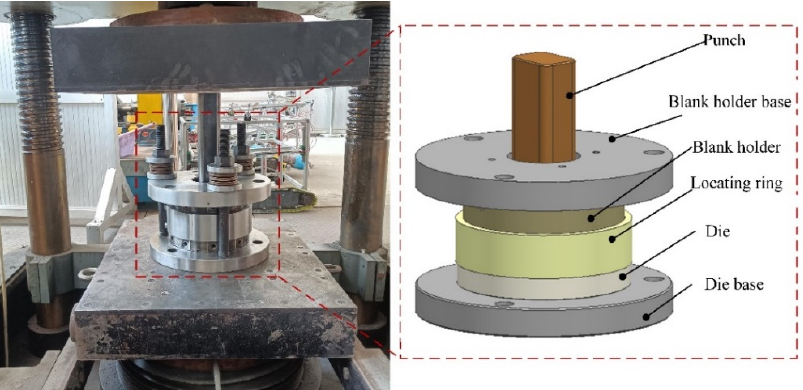
Figure 5. Test Figure 5. Test equipment.